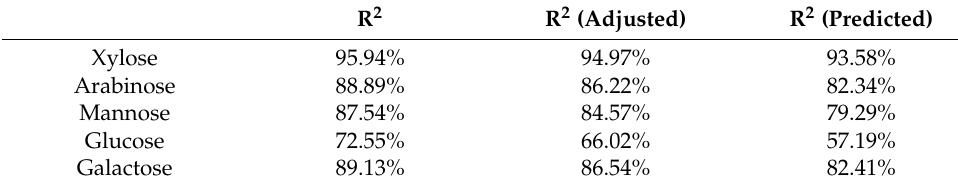
Table 14. Model summary for